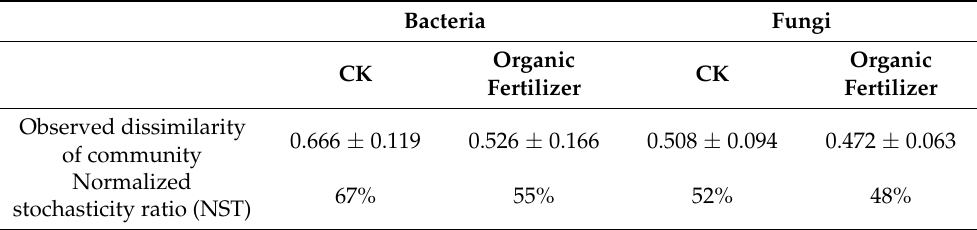
Table 2. Effects of organic fertilizer addition on microbial community